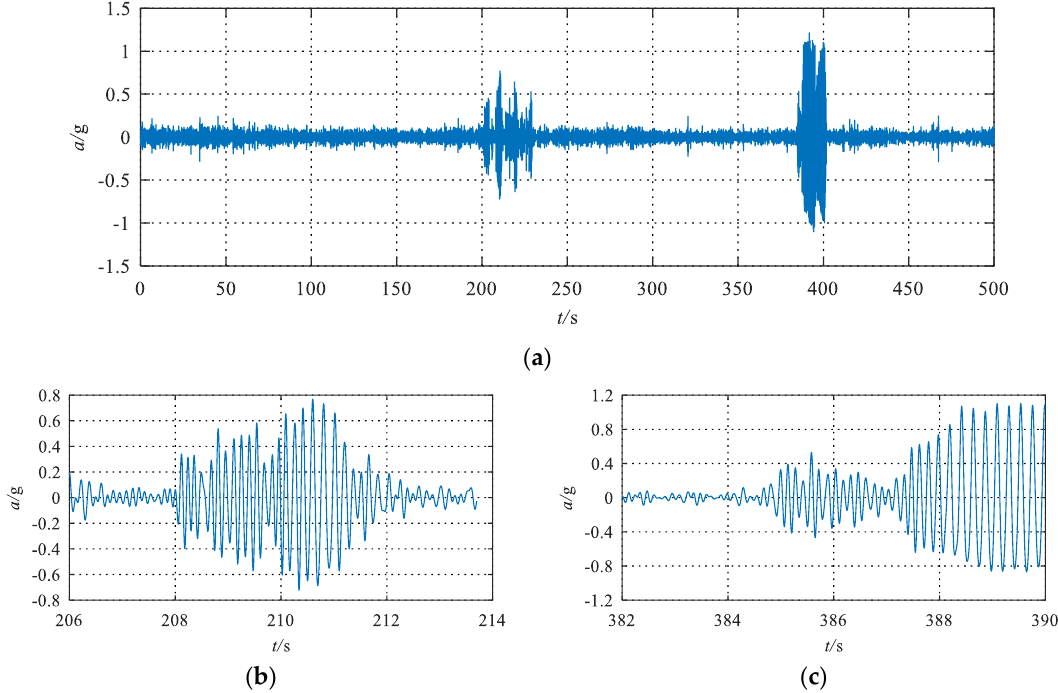
Figure 4. Lateral acceleration signal of the bogie frame when small-amplitude hunting motion occurs during an online test. ( a ) Bogie frame acceleration; ( b ) Small amplitude convergent hunting; ( c ) Small amplitude divergent hunting.